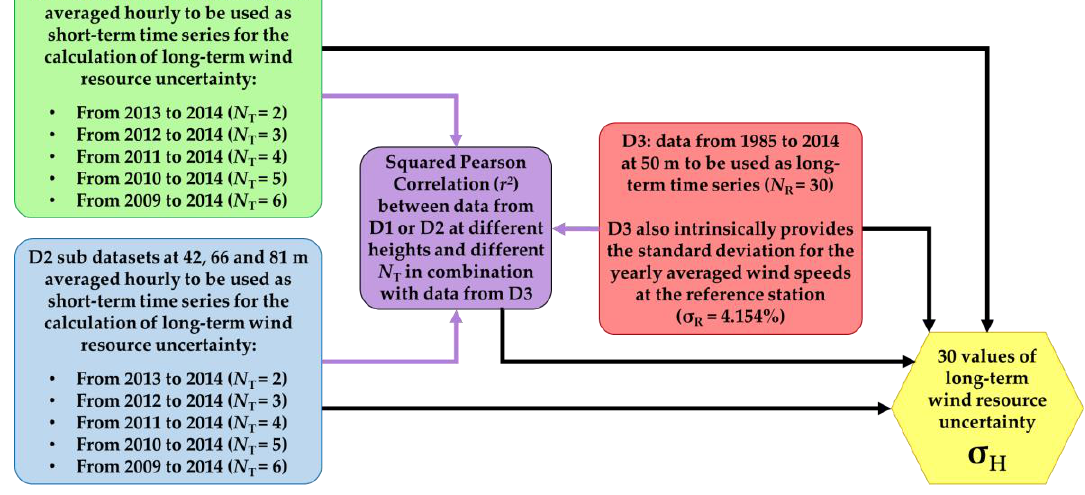
Figure 3. Schematic view of the target location long-term wind resource uncertainty characterization.